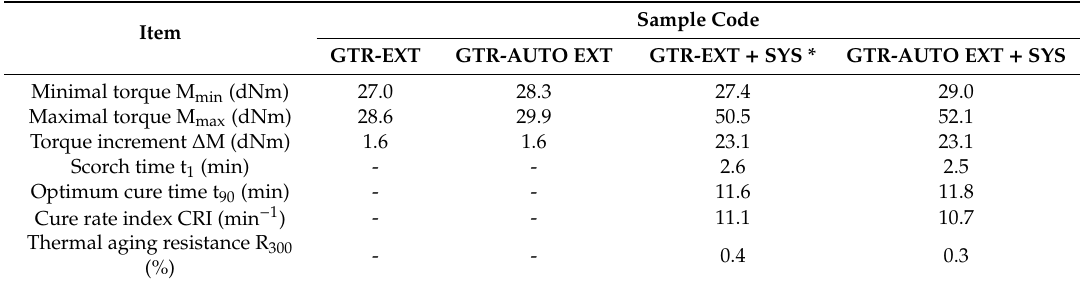
Table 7. Curing characteristics of GTR-EXT and GTR-AUTO-EXT with and without a sulfur curing system.